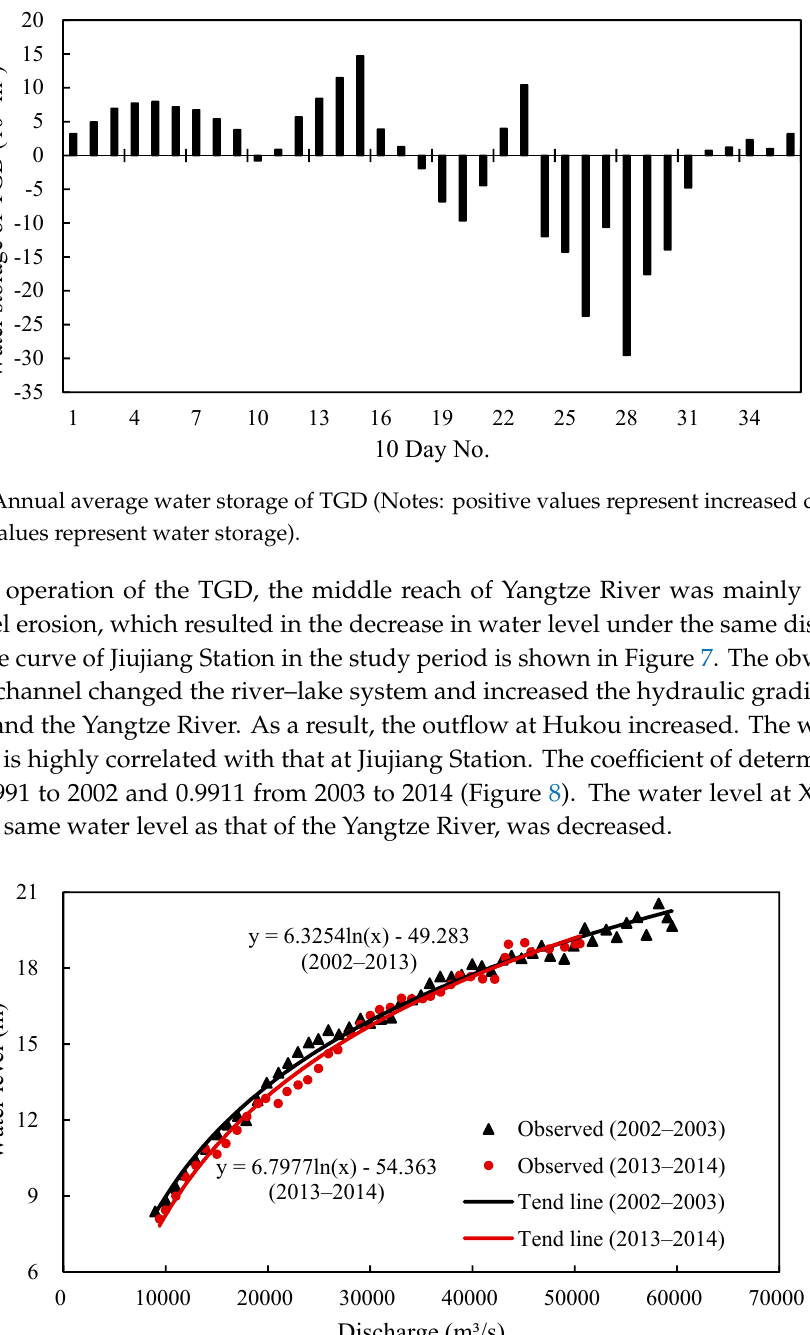
Figure 7. Water level–discharge curve of Jiujiang Station.